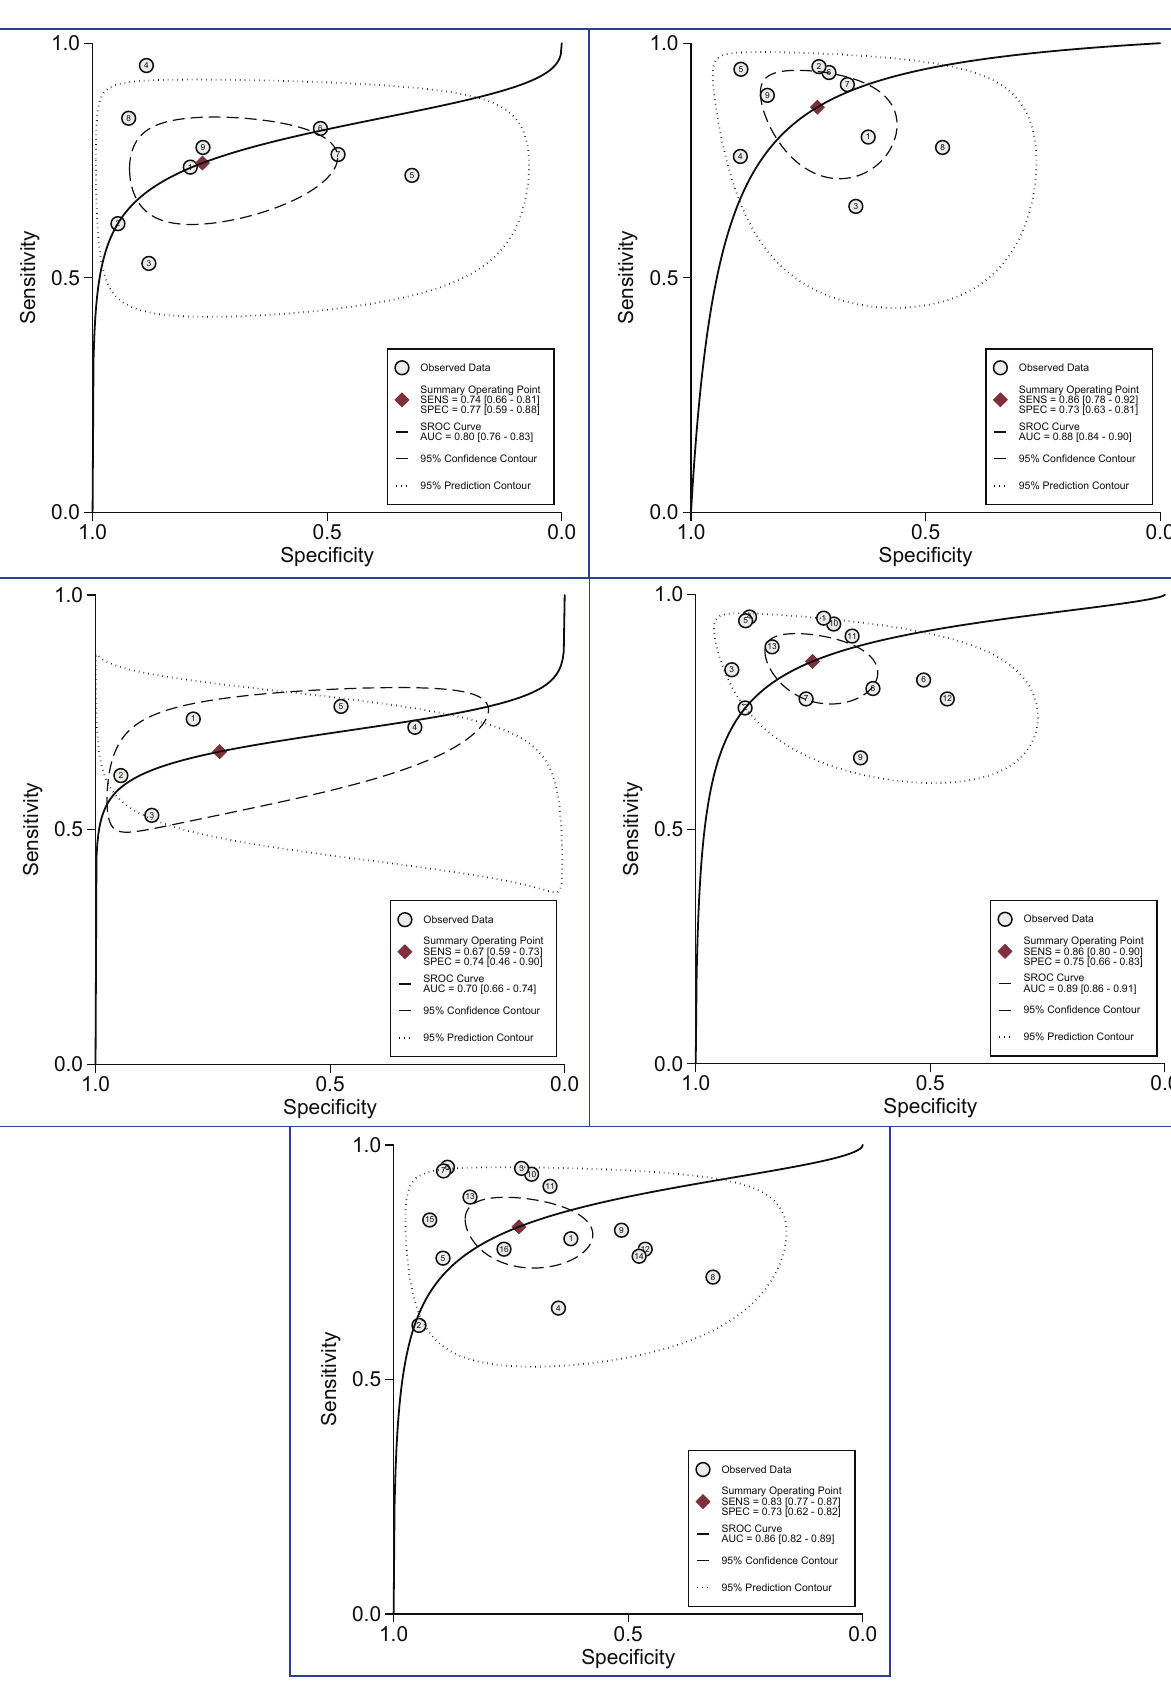
Additional file 3 SROC graph for the subgroup